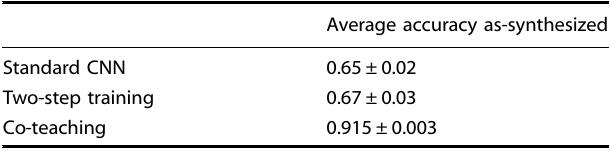
Table 1. The average accuracy and standard error on the error-free, as-synthesized balanced test set for each of the three